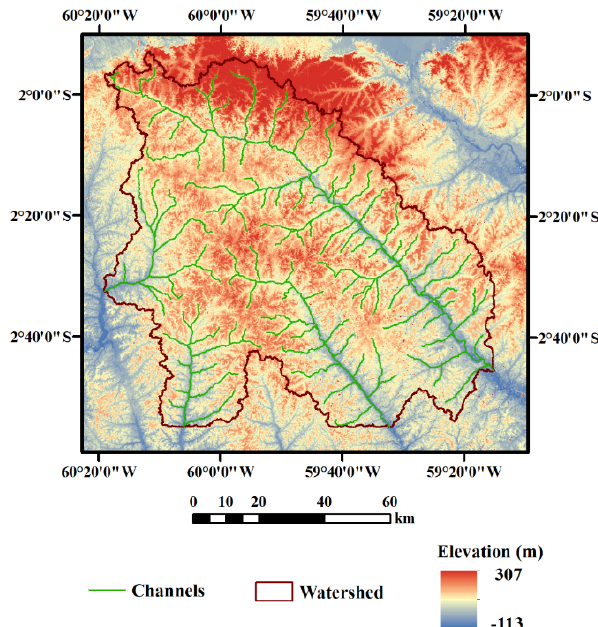
Figure 1. Two-dimensional map of the watershed used in this study, showing the elevation, channels, and watershed boundary. The study area extends from 1 ◦ 57 (cid:48) 36 (cid:48)(cid:48) to 2 ◦ 56 (cid:48) 00 (cid:48)(cid:48) S and from 59 ◦ 14 (cid:48) 48 (cid:48)(cid:48) to 60 ◦ 20 (cid:48) 0 (cid:48)(cid:48)